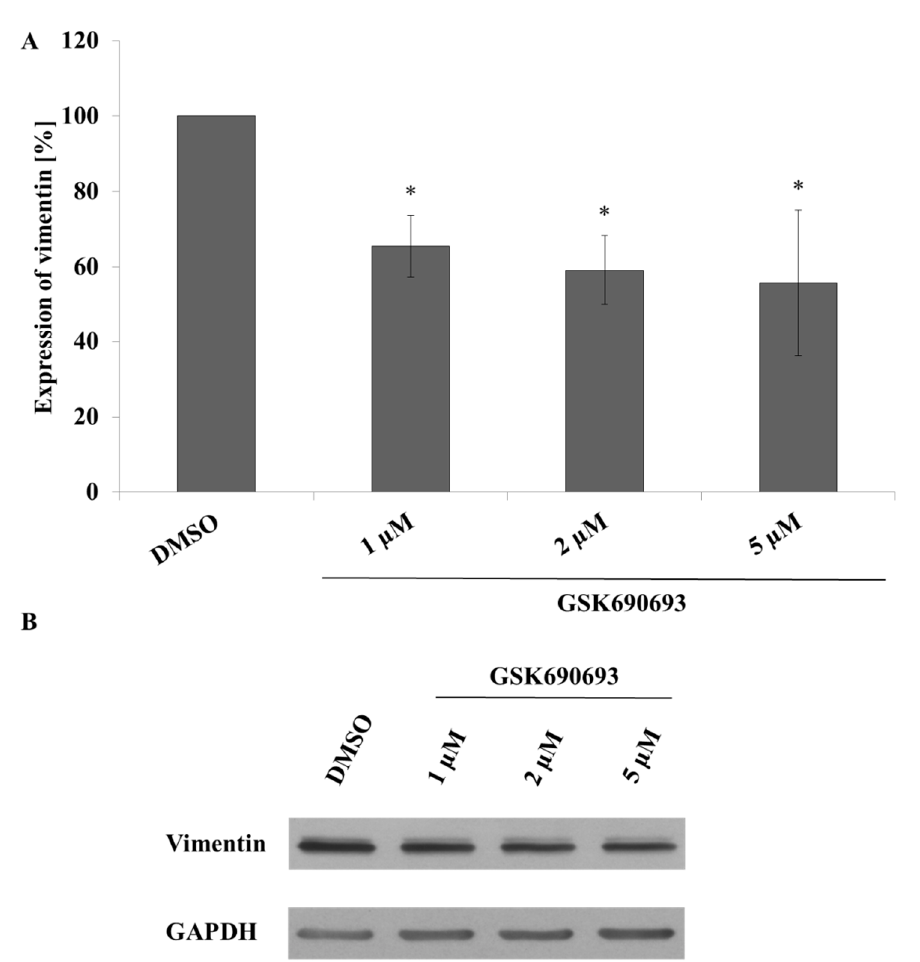
Figure A5. Modulation of vimentin expression by GSK690693. Panel ( A ): Hep G2 cells were seeded and incubated with different concentrations of GSK690693 or negative control (contains only DMSO). Vimentin expression was evaluated by Western blot after 24 h of incubation. Each bar represents mean ± SD of three independent experiments. Panel ( B ): representative Western blot * p < 0.05 versus negative control.